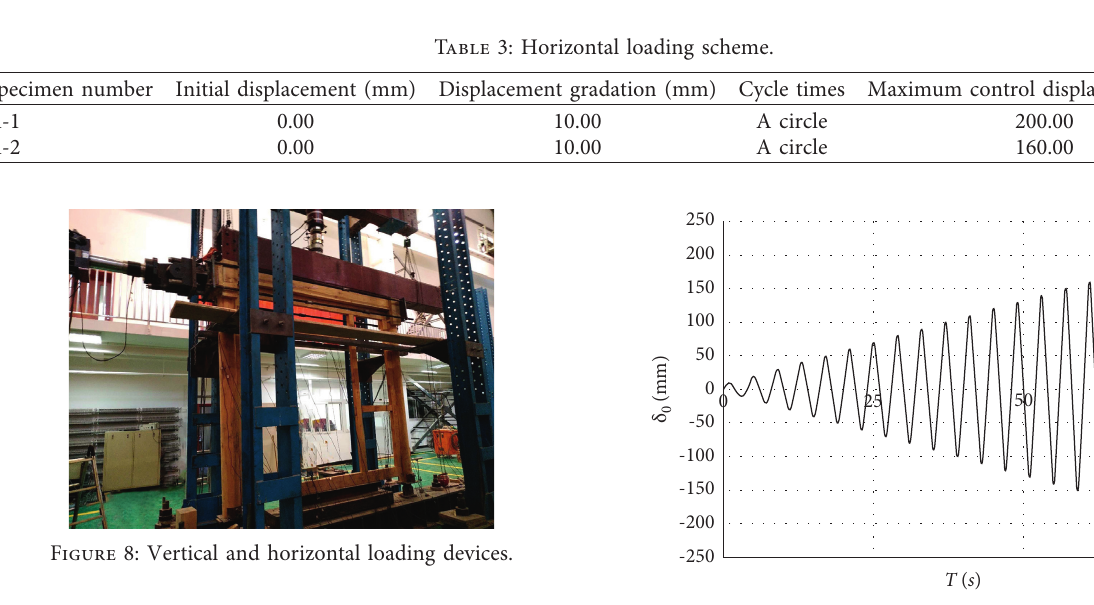
Figure 11: Displacement loading curve.